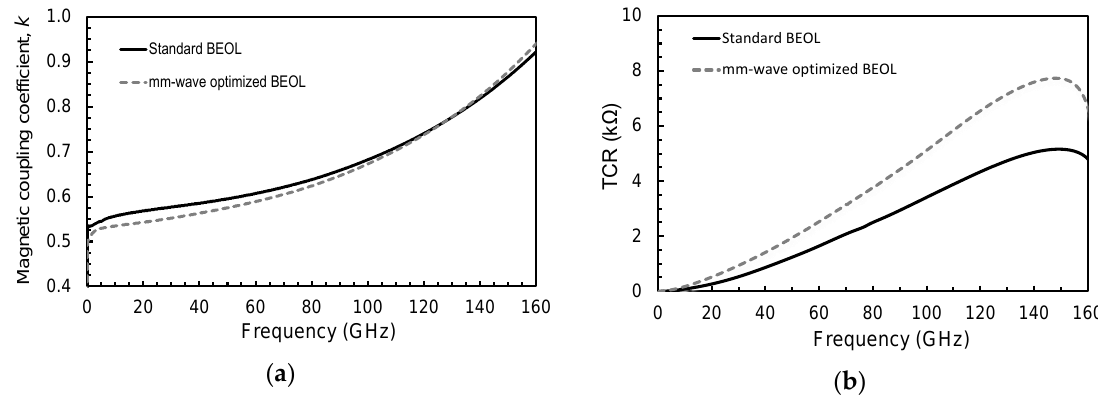
Figure 8. BEOL comparison for stacked transformer T 1 of Table 1. ( a ) magnetic coupling coe ffi cient, k ; ( b ) transformer characteristic resistance, TCR